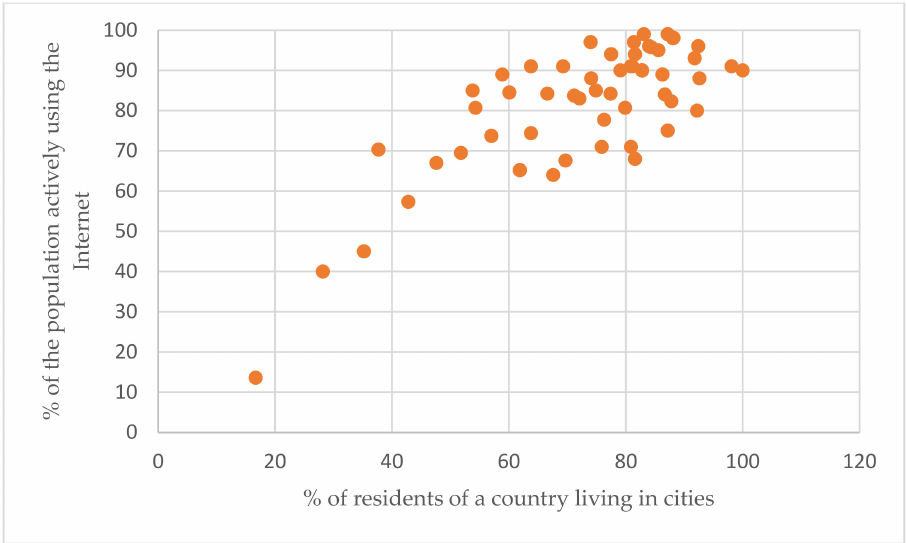
Figure 3. Country urbanization and the percentage of people using the Internet. Source: author’s work based on